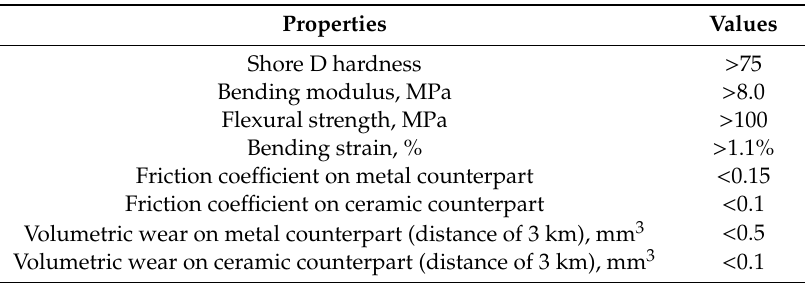
Table 4. Specified operational properties for the PPS-based composites.